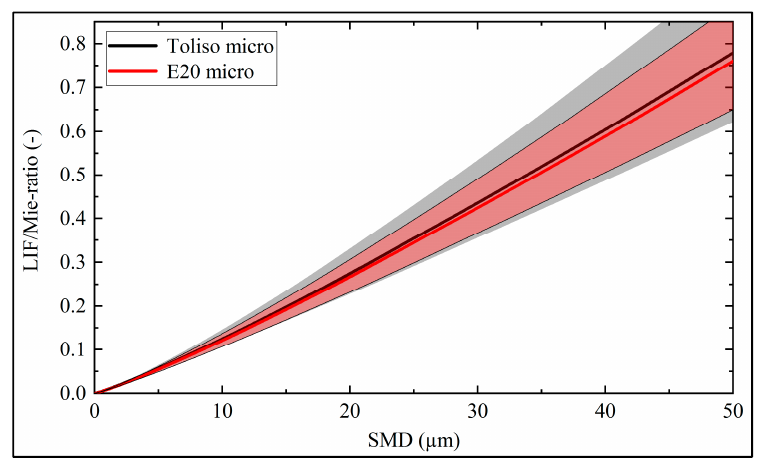
Figure 6. Fitting curve of the experimental data plotted for the LIF/Mie ratio as a function of the droplet diameter for Toliso and E20 at the reference conditions (293 K, nile red 100 mg/l).